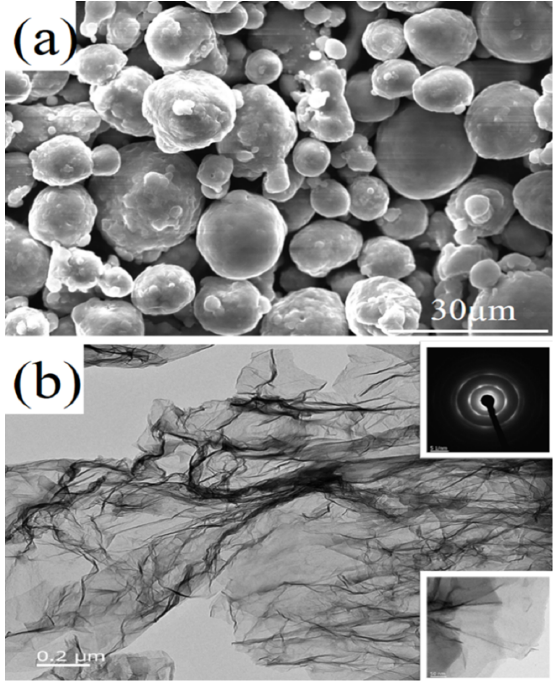
Figure 1. Al powder and GNP. ( a ) SEM of pure Al powder; ( b ) TEM of GNP.